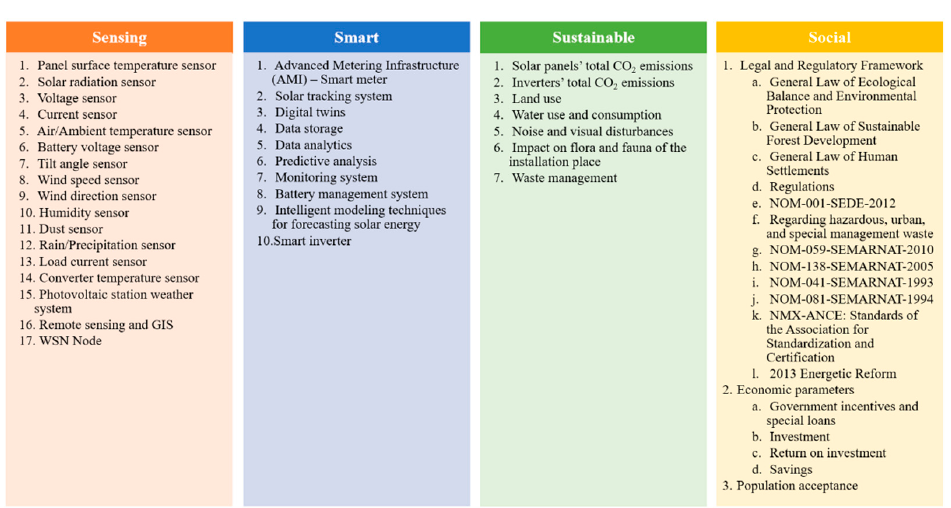
Figure 1. S4 Framework